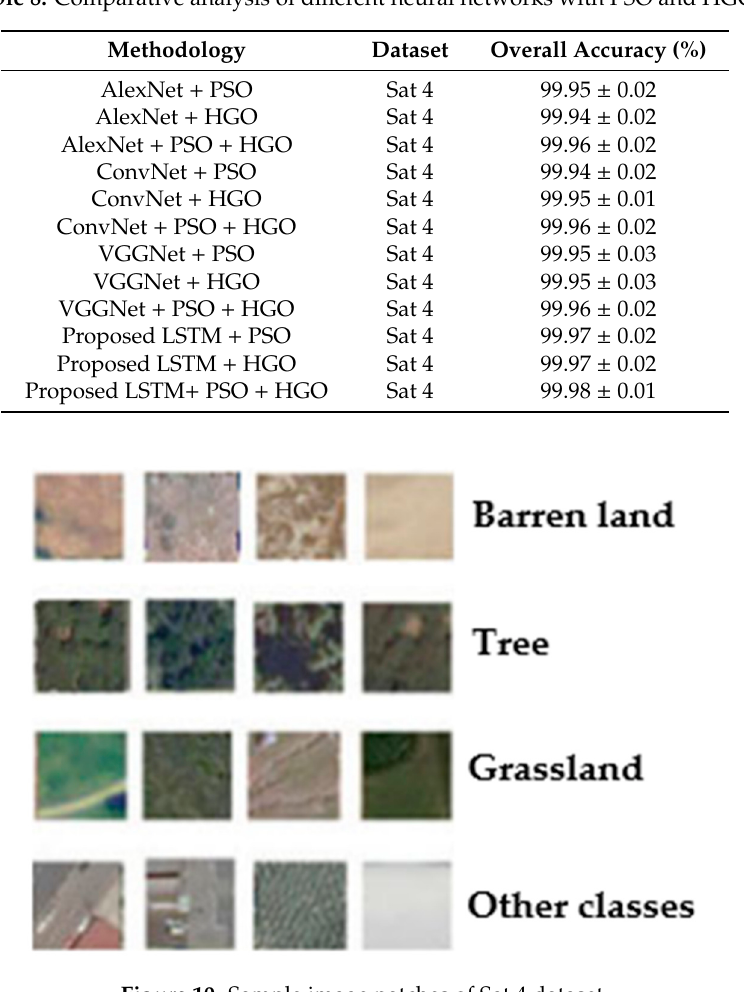
Table 9. Performance investigation of the proposed model with different classifiers on Sat 6 dataset by means of recall and precision.